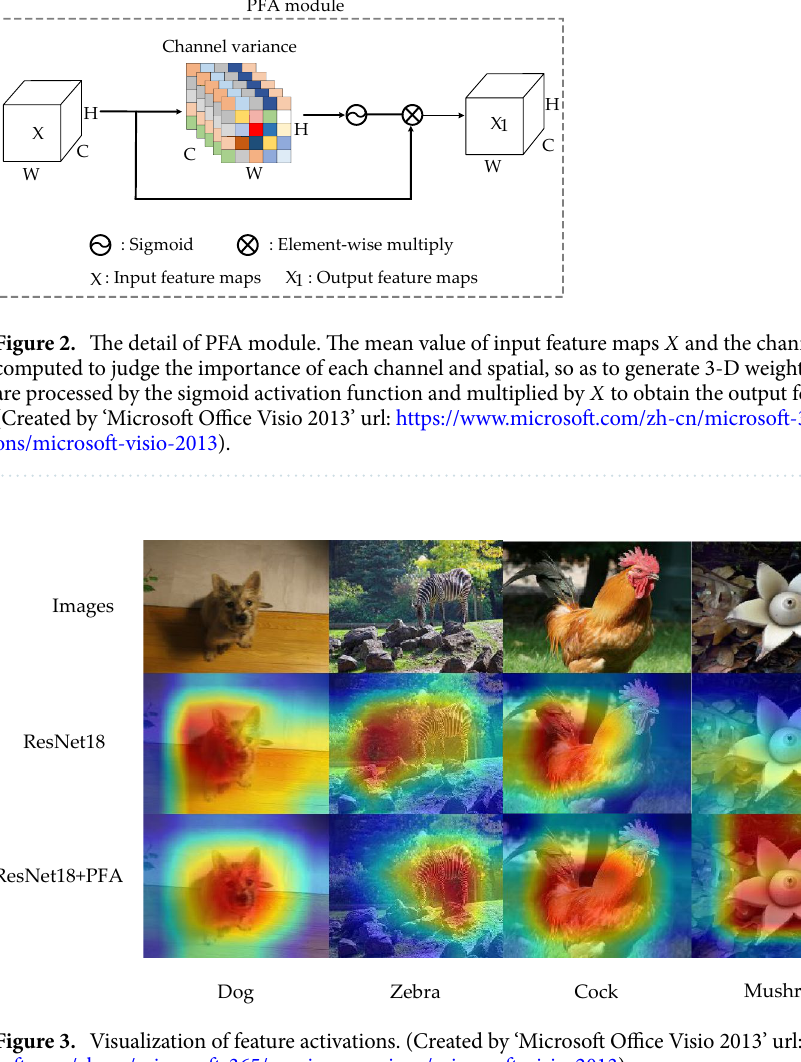
Figure 3. Visualization of feature activations. (Created by ‘Microsoft Office Visio 2013’ url: https:// www. micro soft. com/ zh- cn/ micro soft- 365/ previ ous- versi ons/ micro soft- visio-